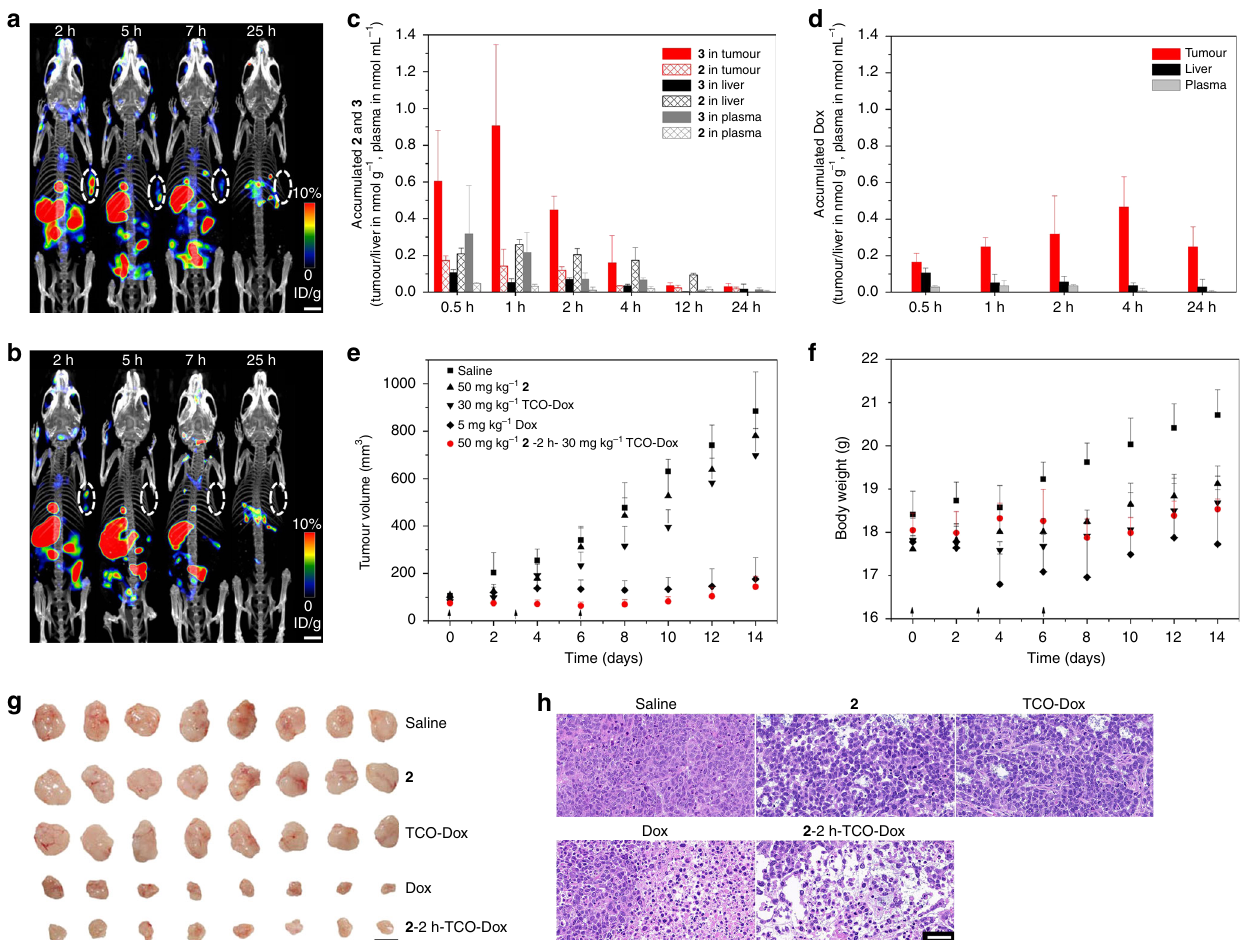
Fig. 5 Biodistribution of self-assemblies and in vivo prodrug activation to inhibit tumour growth. a , b SPECT/CT imaging demonstrated the distribution of 2 at different time points after i.v. administration of a a mixture of 50 mg kg − 1 2 and 0.875 mg kg − 1 125 I-labelled 2 (700 μ Ci) and b 0.875 mg kg − 1 125 I- labelled 2 (700 μ Ci) alone. Tumour sites are highlighted by white circles. Scale bars, 5 mm. c UPLC-MS/MS analysis of the pharmacokinetics of 2 and 3 in the tumour, liver and plasma after i.v. injection of 50 mg kg − 1 2 ( n = 5). The results demonstrated the selective accumulation of 3 in tumours over liver or plasma. d UPLC-MS/MS analysis of activated Dox in tumour, liver and plasma after treatment [i.v. injection of 50 mg kg − 1 2 followed by i.v. injection of 30 mg kg − 1 TCO-Dox after a 2-h interval] ( n = 5). The results demonstrated the effective enrichment of activated Dox in tumours over liver or plasma. e Tumour growth curves for mice after i.v. injection with saline, 50 mg kg − 1 2 , 30 mg kg − 1 TCO-Dox, 5 mg kg − 1 Dox and 50 mg kg − 1 2 – 2 h-30 mg kg − 1 TCO- Dox ( n = 8). The arrows on the x -axis indicate treatment duration in days. f Quanti fi cation of mouse weights in each group of ( e ). Error bars indicate standard deviation. g Photograph of dissected tumour samples after treatment for 14 days. Scale bar, 10 mm. h Representative histological examination results of the dissected tumours using HE staining. Scale bar, 50 μ